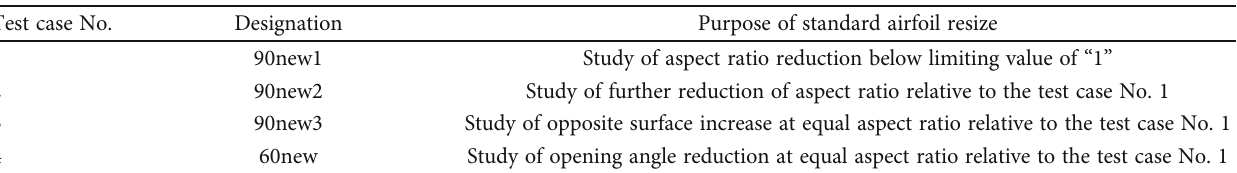
Figure 1: Modi fi ed AR variants of splitting airfoil. (a) 90new1. (b) 90new2. (c) 90new3. (d) 60new. (e) 90 ° standard. (f) AR and S Table 1: Design characteristic of modi fi ed aspect ratio variants. Test case